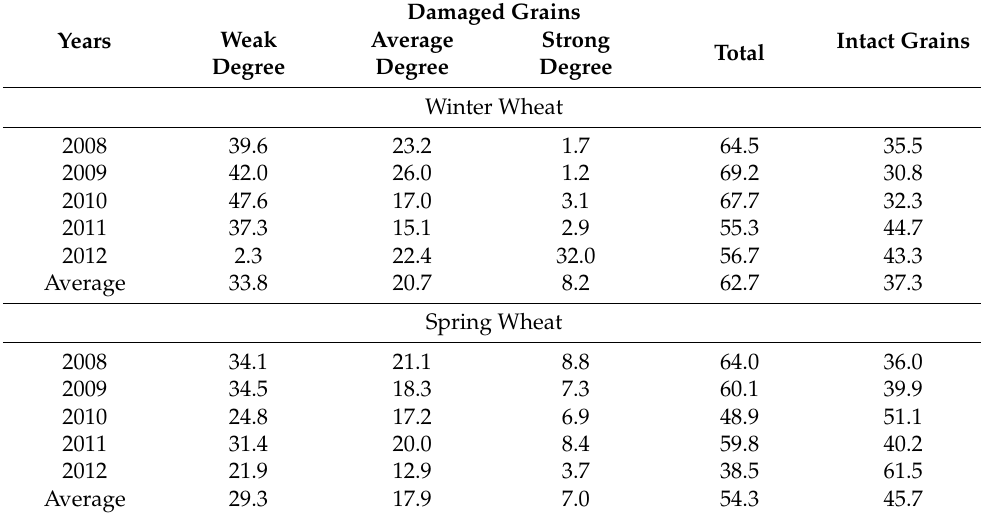
Table 3. The degree of damage to the grain of winter and spring wheat in 2008–2012,